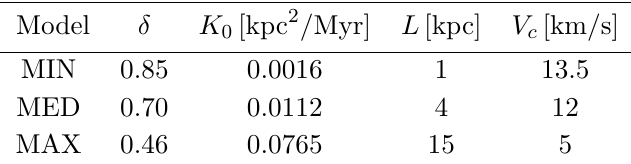
Table 2 . Parameters for propagation models MIN, MED and MAX. L is the height of the galactic disc, V c the magnitude of the galactic wind, and K 0 and (cid:14) are the parameters of eq.